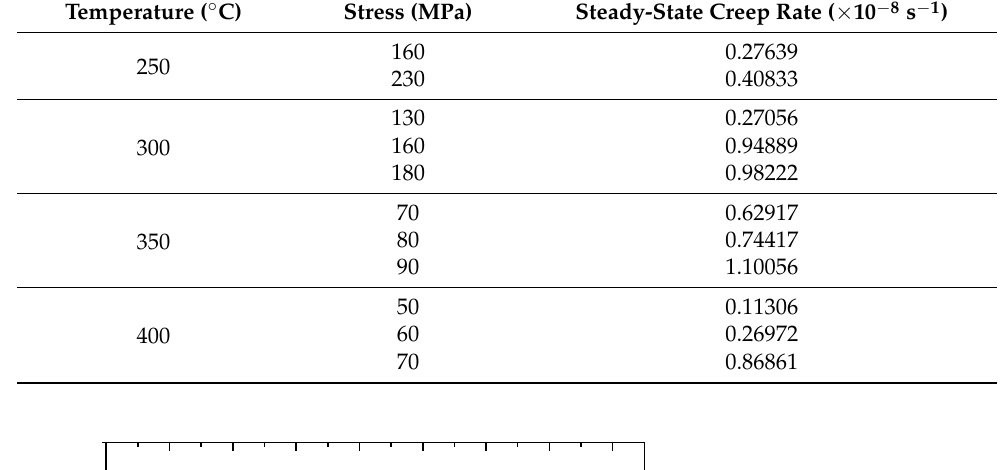
Table 3. Creep properties of the alloys at different stresses and temperatures.